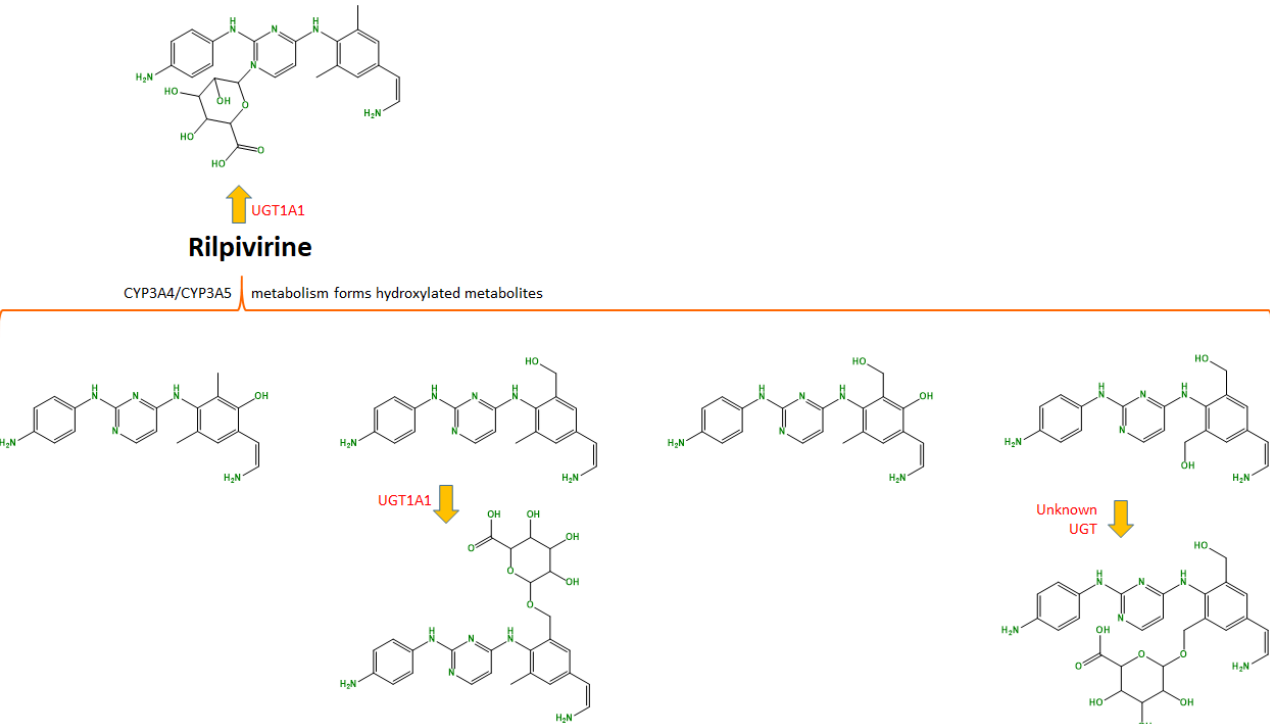
Figure 2. Rilpivirine is administered orally and suffers hepatic metabolism from CYP3A4 and, to a lesser degree, CYP3A5, into several hydroxylated metabolites, and some are then glucuronidated by UGT1A1 and an unknown glucuronidate. It can also be glucuronidated directly by UGT1A1. (Developed with ChemBioDraw ® Ultra 13.0. A Chemical Drawing Software. Available online: https://chemdrawdirect.perkinelmer.cloud/js/sample/index.html (accessed on 22 December 2022).)